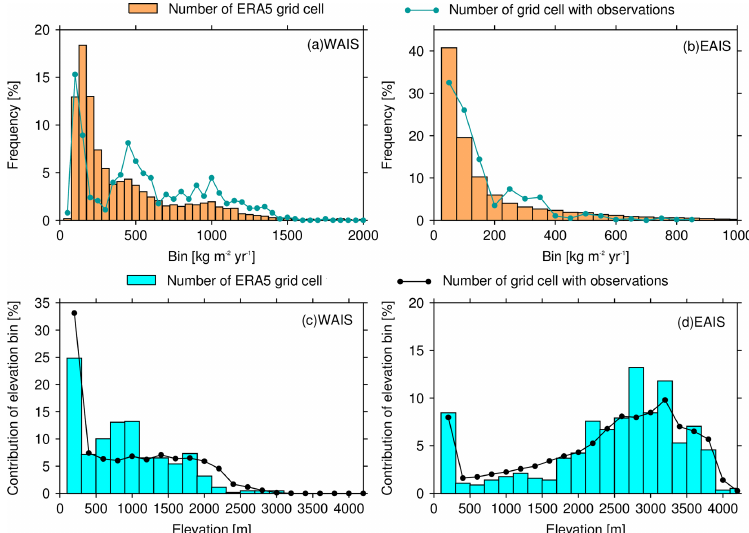
Figure 6. Relative frequency of ERA5 P − E field data and gridded averaged records from the multi-year-averaged SMB subdatabase, with a bin range of 50kgm − 2 yr − 1 on (a) the West Antarctic Ice Sheet (WAIS) and (b) the East Antarctic Ice Sheet (EAIS). ERA5 field data are bilinearly interpolated over a 30km Cartesian grid. We average SMB for each 30 × 30km grid cell (values from points located in the same grid cell are averaged), and then the number of grid cells in each bin is calculated. The contribution of the area of the elevation bin for ERA5 grid cells containing measurements and the entire elevation range to (c) the WAIS and (d) the EAIS. The 200m elevation bins are used.